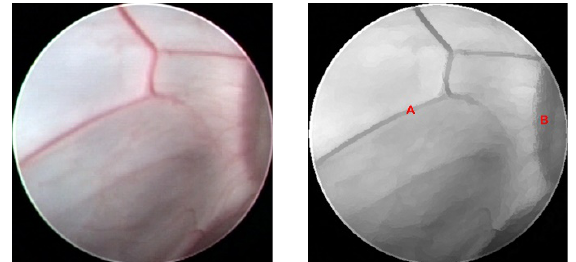
Fig. 10. Septal veins (A), anterior septal vein (B).